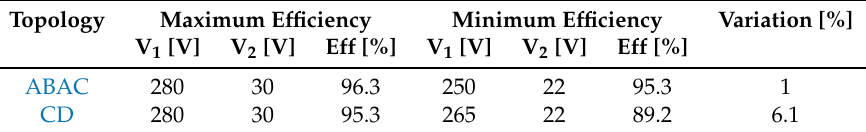
Figure 8. Efficiency map at full power, in boost mode. DAB topologies performance in boost mode is the same that in buck mode, as shown in Figure 7. Table 5. Maximum and minimum full power efficiency map values in boost mode.